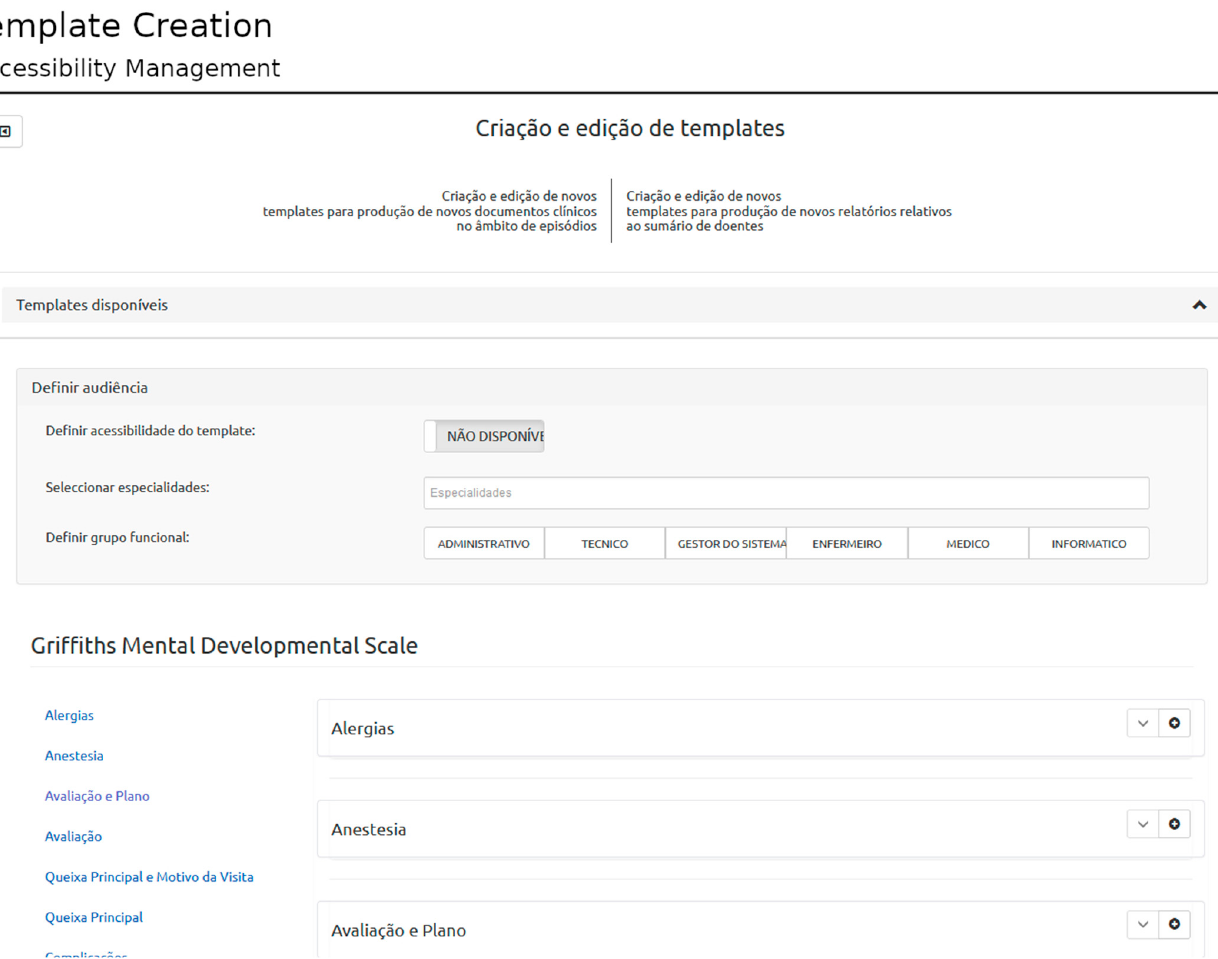
Figure 5. Template building: accessibility management. In this section of template building, the user